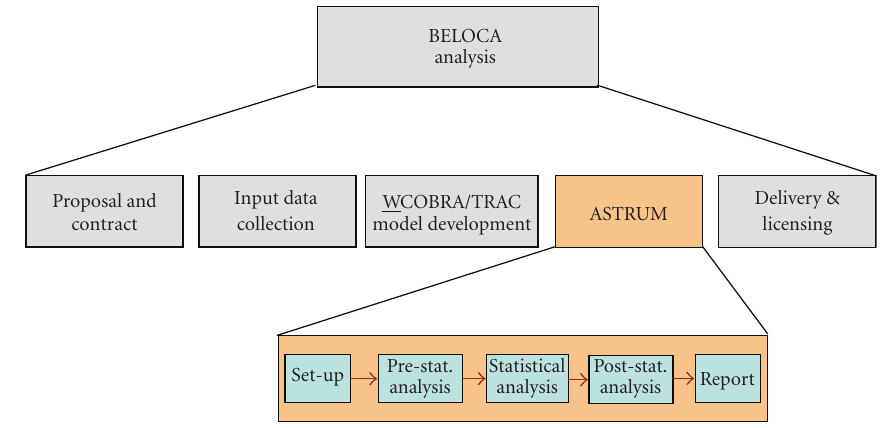
Figure 6: Flow chart of a typical BELOCA analysis.